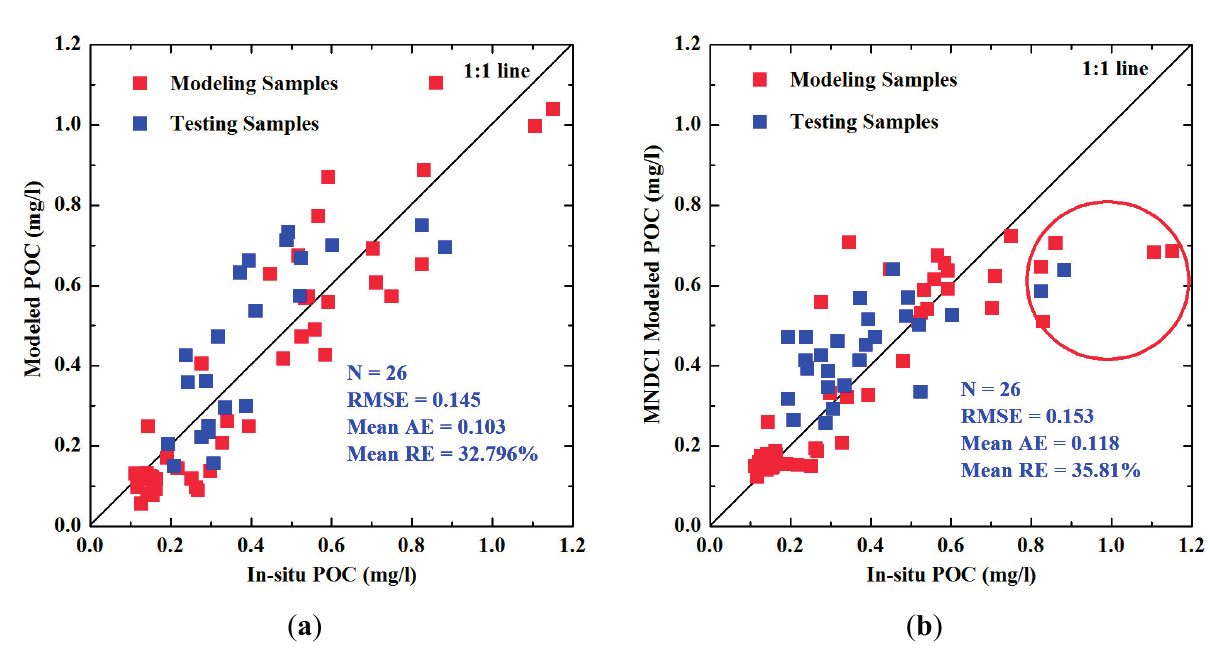
Figure 3. Comparisons between in situ POC and modeled POC concentrations using the algorithm developed in this study ( a ) and by Son et al. [3] ( b ). AE and RE are defined in Equation